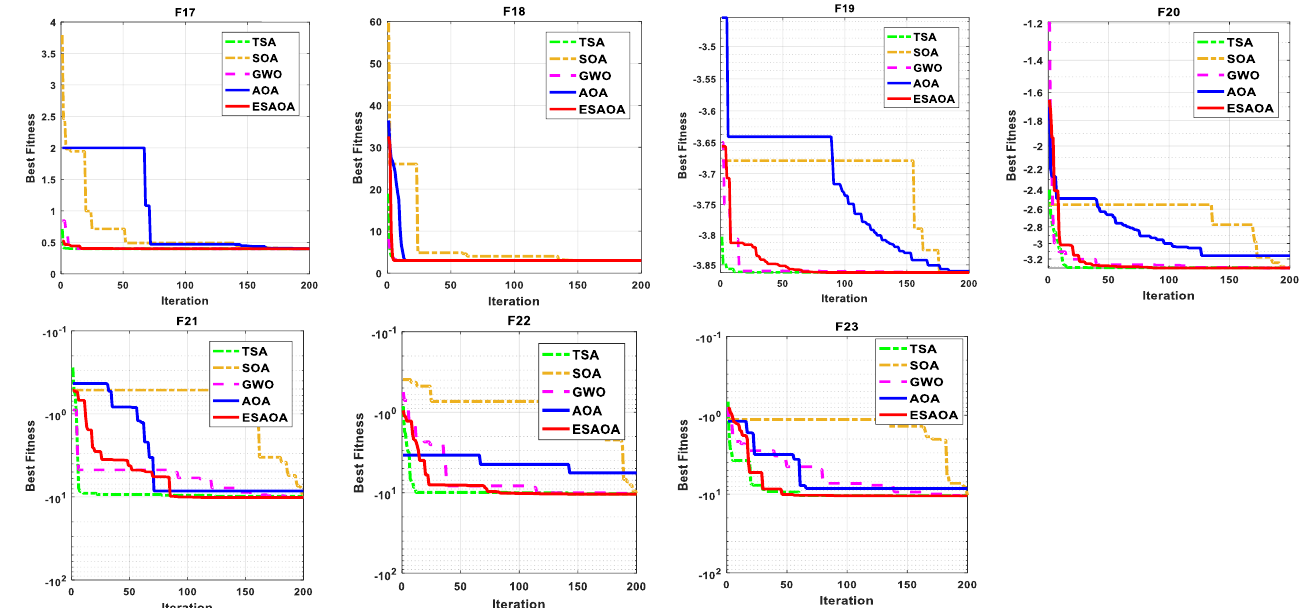
Figure 12. The convergence curves of all algorithms for 22 benchmark functions.